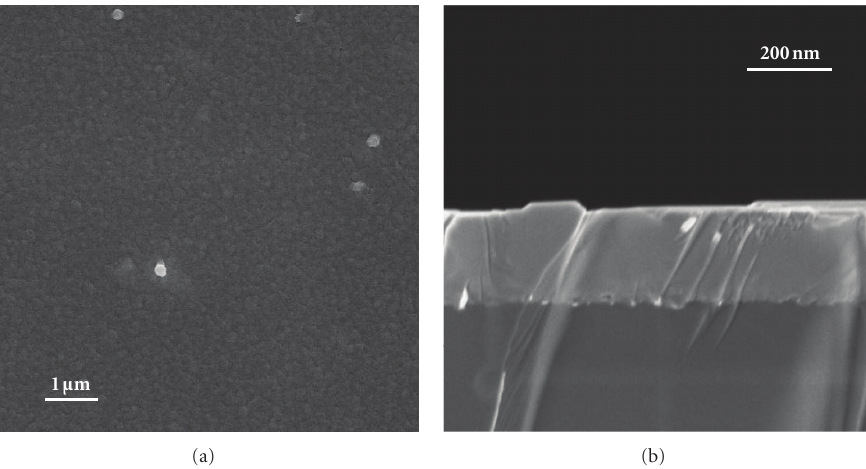
Figure 1: (a) Top view SEM image of an Si substrate covered with Au evaporated at room temperature and Ge evaporated at 480 ◦ C; native SiO 2 has not been removed before Ge evaporation. (b) Cross-section SEM image of the sample shown in (a). The 2D Ge layer on Si substrate is clearly